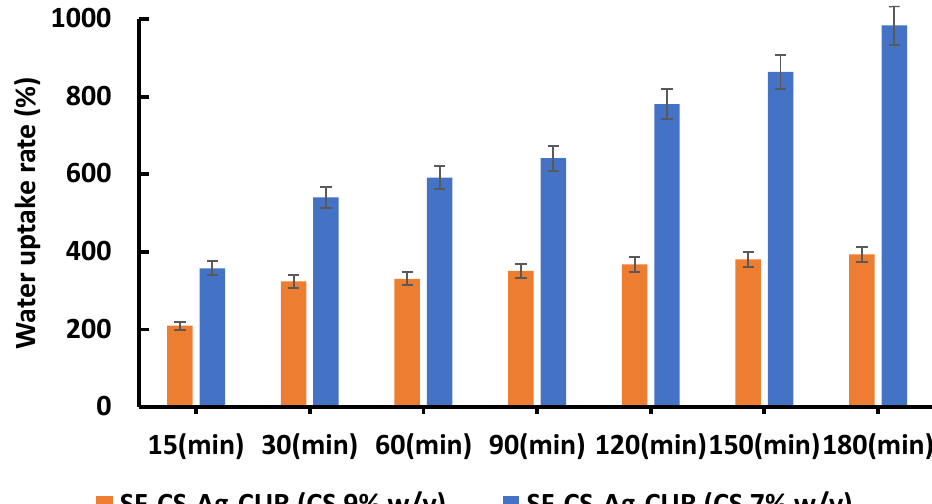
Figure 6. Water uptake profile of SF-CS-Ag-CUR (CS 7% w / v ) and SF-CS-Ag-CUR (CS 9% w / v ).